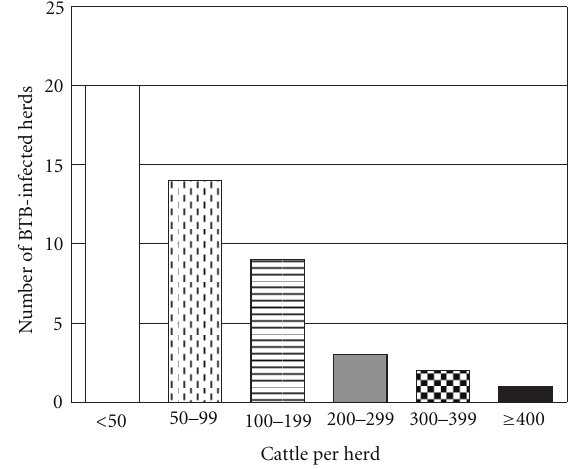
Figure 3: Herd sizes of BTB-infected cattle herds in Michigan, 1998–July